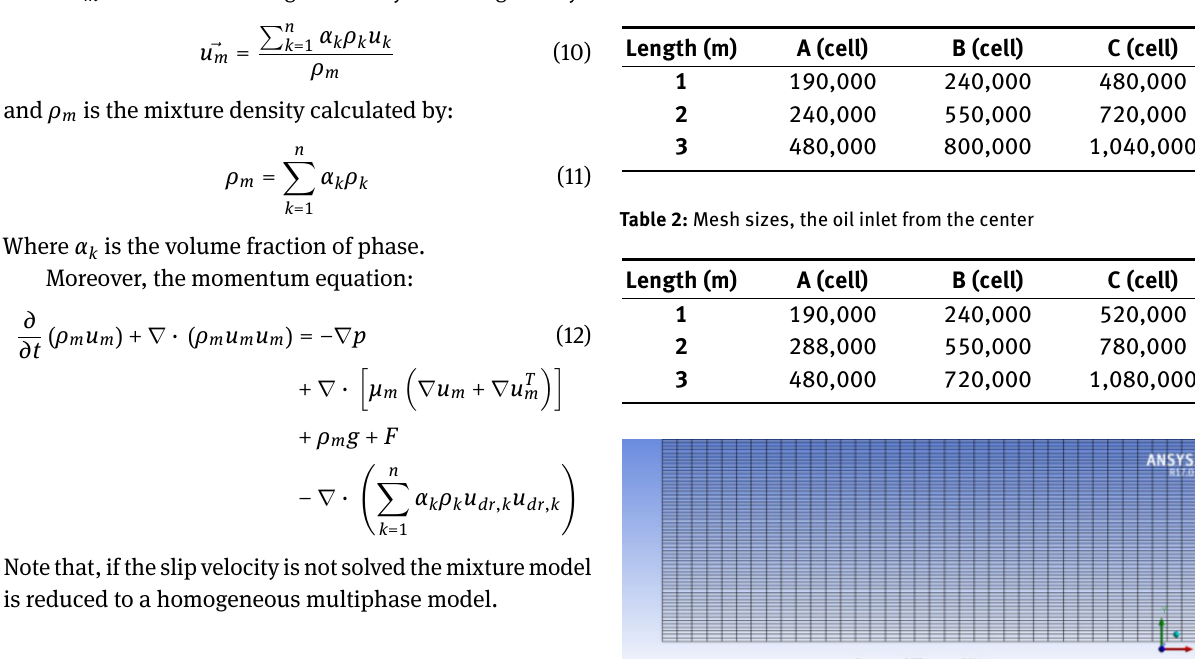
Table 1: Mesh sizes, the oil inlet above the water